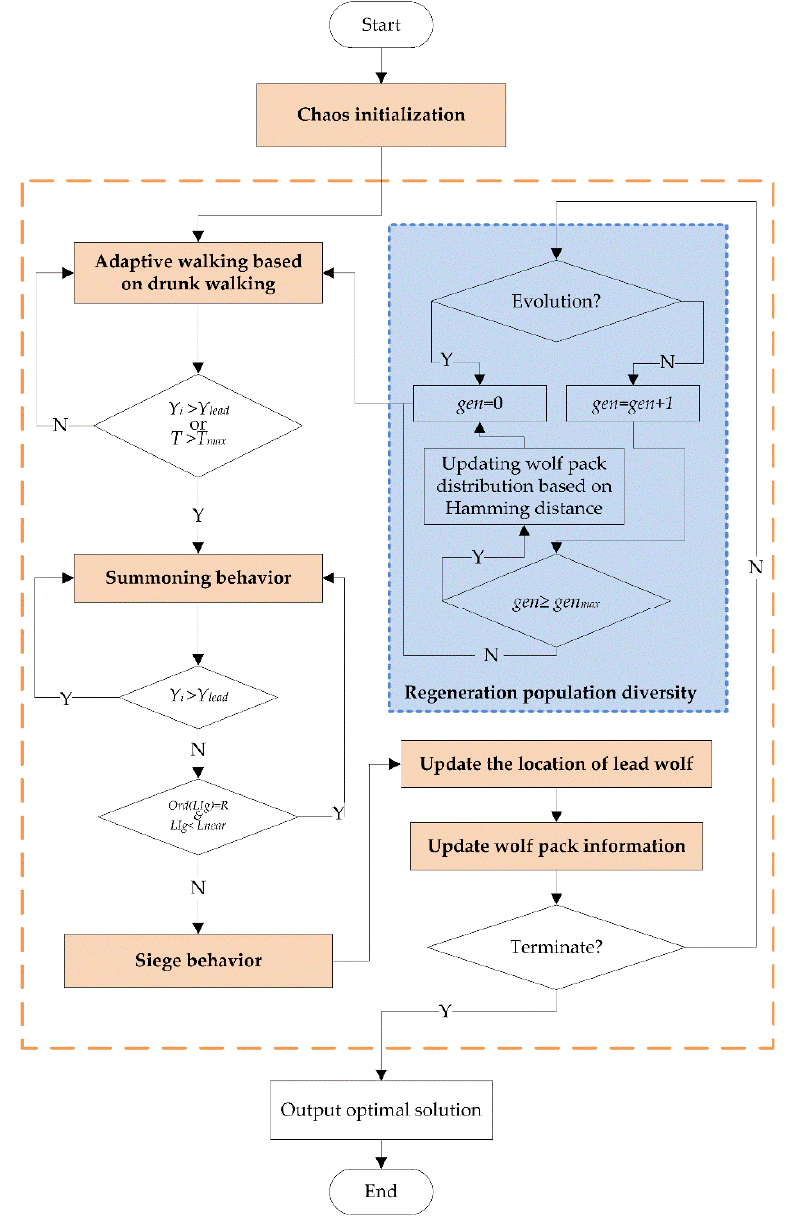
Figure 10. Flowchart of the improved algorithm.